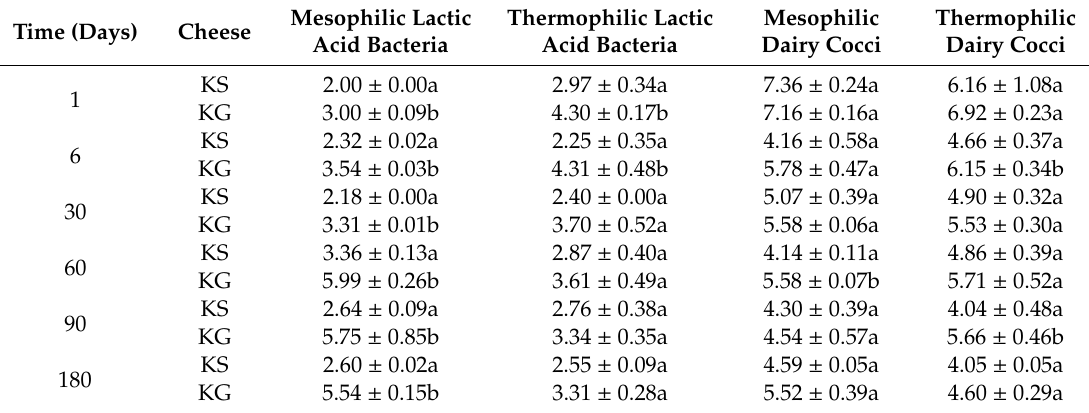
Table 8. Microbial changes (log cfu g − 1 ) of kashkaval of Pindos cheese made from 100% sheep milk (KS) or a mixture of 90% sheep milk and 10% goat (KG) milk during ripening and storage.